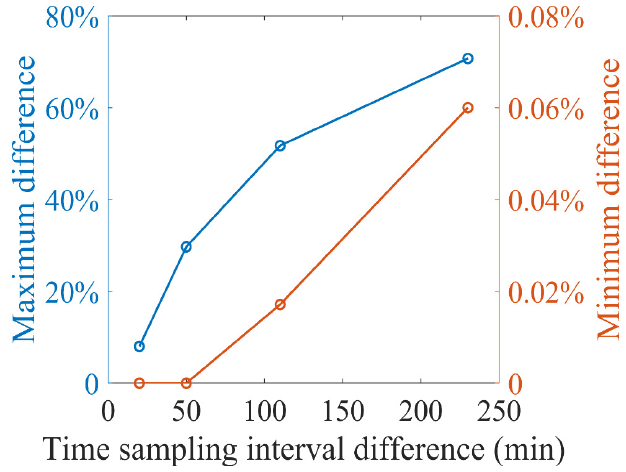
Figure 9. Variation in maximum and minimum differences of the ANCI ratio with the time sampling interval difference.